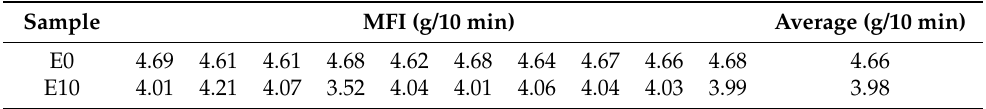
Table 4. Results of Melt Flow Index.